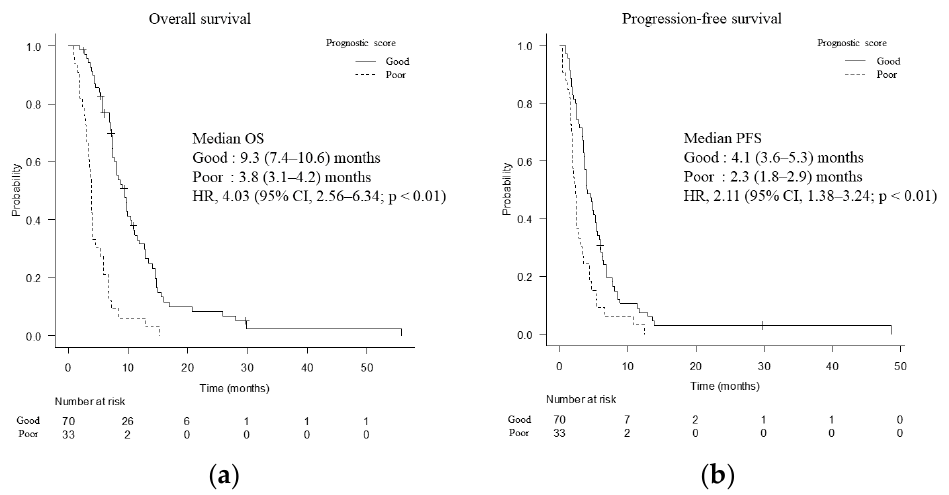
Figure 3. Overall survival ( a ) and progression-free survival ( b ) divided by prognostic factors. OS, overall survival; HR, hazard ratio; CI, confidence interval; PFS, progression-free survival.